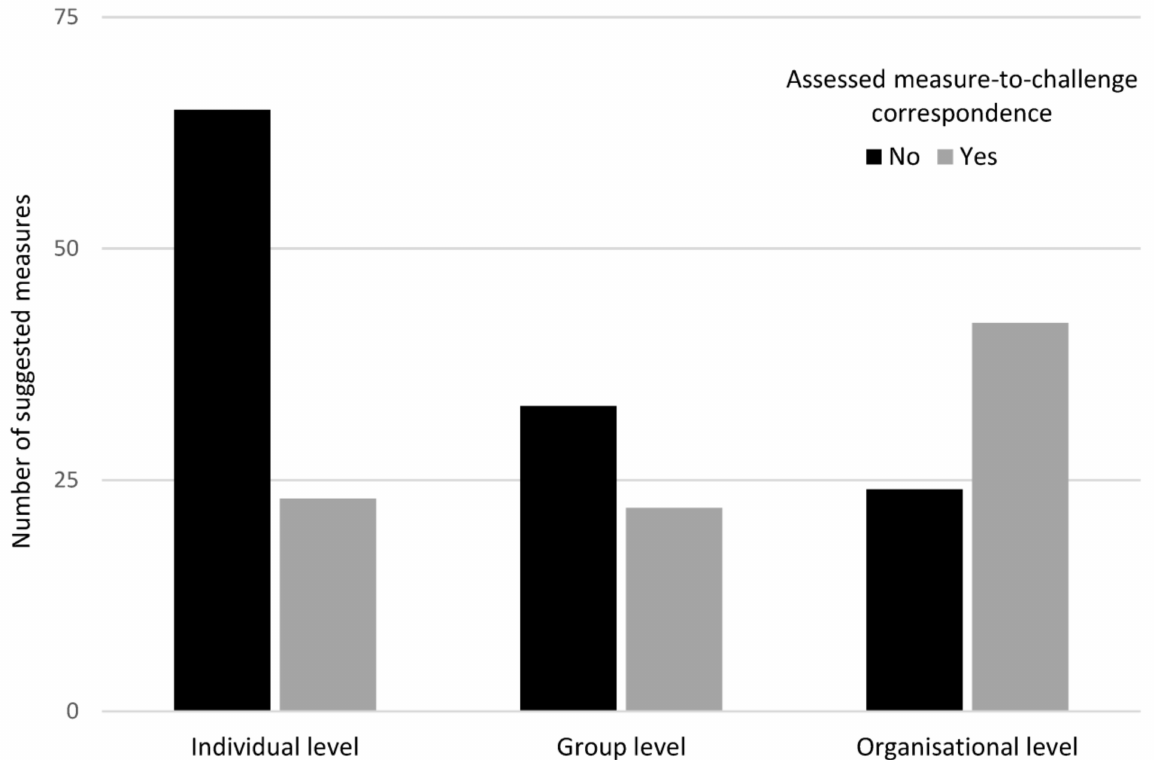
Figure 3. Number of suggested measures ( n = 209 in total) divided by the level of the measures and stratified by measure- to-challenge correspondence